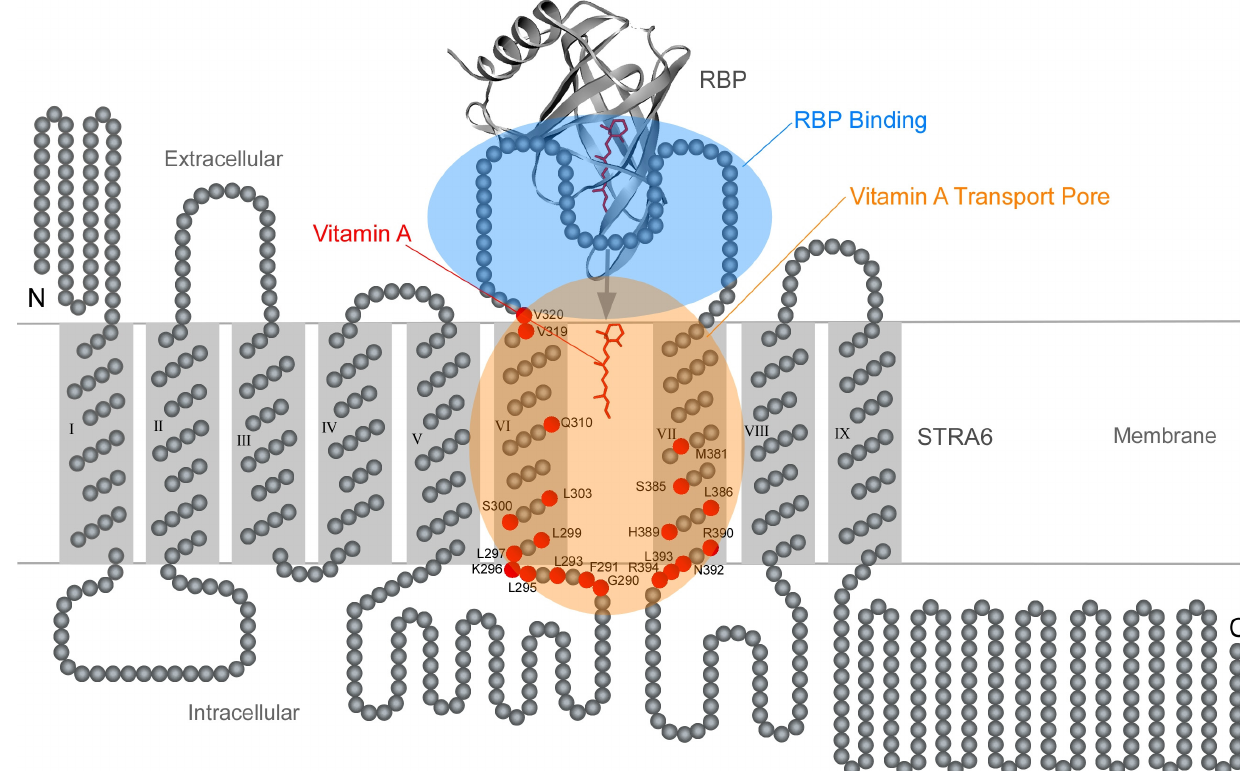
Figure 7. Schematic diagram of the locations of key positions in STRA6 whose acute modifications block vitamin A transport by STRA6. The transmembrane topology model of STRA6 is depicted together with the crystal structure of holo-RBP. STRA6’s key RBP binding domain is shaded in blue. The transmembrane domains and adjacent regions that are known to be part of the vitamin A transport pore are shaded in orange. Residues whose acute modification impedes vitamin A transport by STRA6 are represented as red